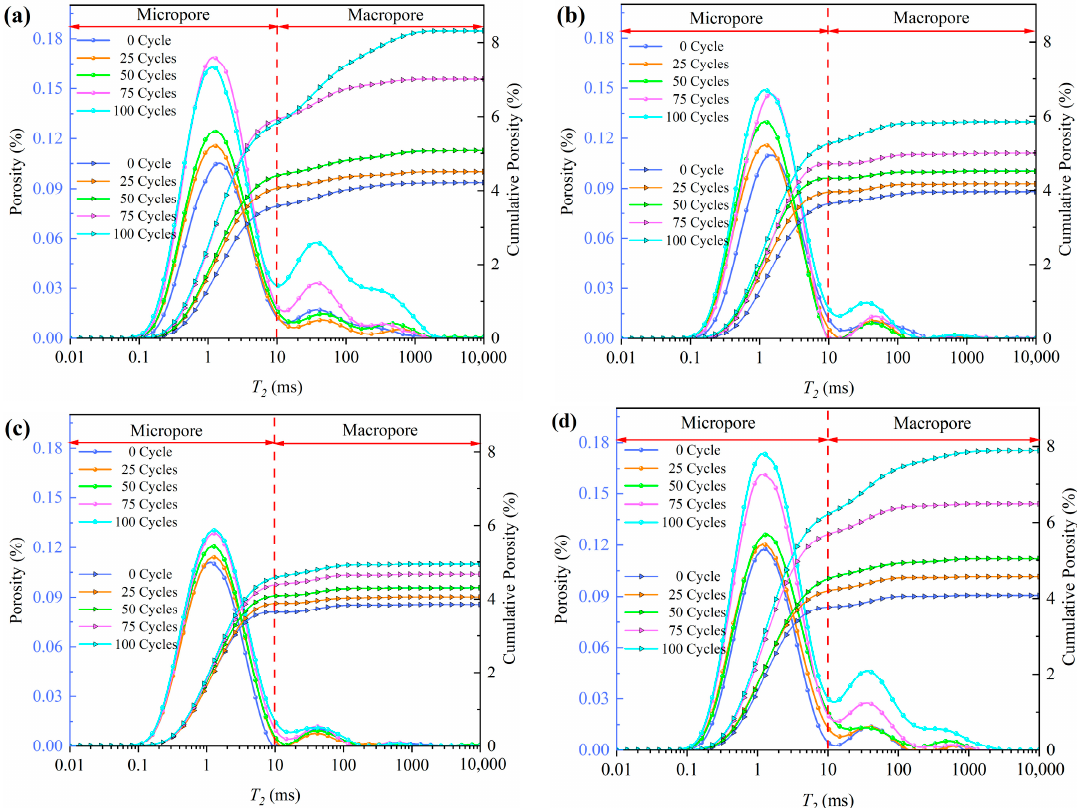
Figure 4. Changes of pore distribution with freeze-thaw cycles. ( a ) A1, ( b ) A2, ( c ) A3, ( d ) A4.